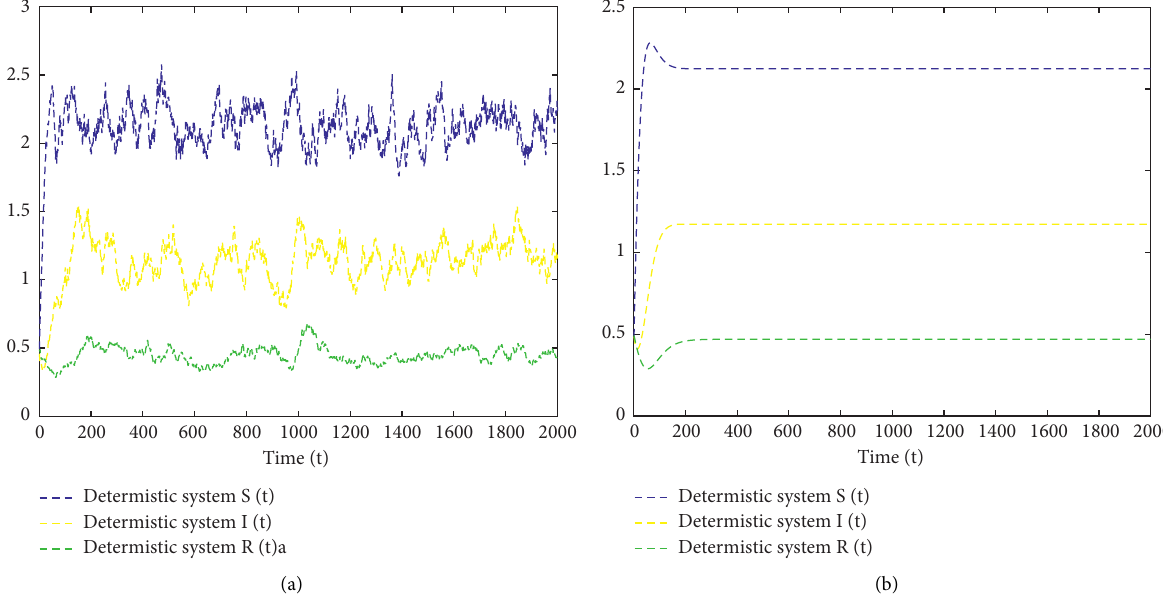
Figure 3: The subgraphs (a) and (b) denote the numerical simulation of the stochastic system (15) with R s > 1, respectively. This shows that the disease will be permanent in a long (1) with R 0